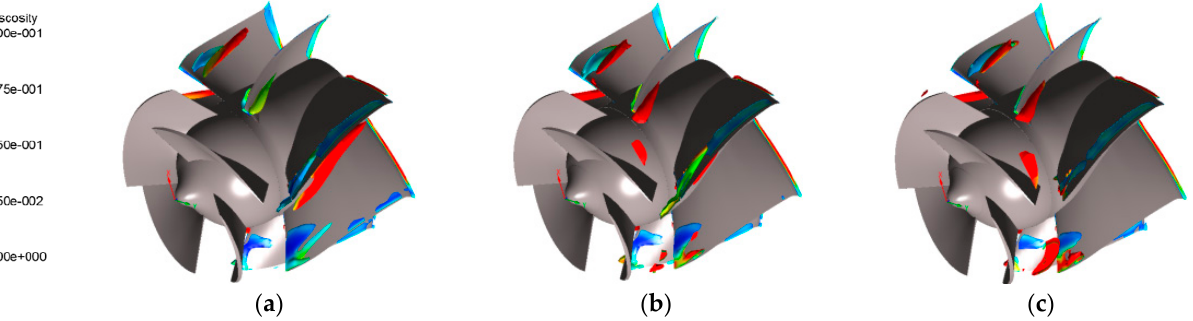
Figure 13. Vortex core distribution in guide vane, ( a ) e = 0 mm, ( b ) e = 3 × 10 − 1 mm, ( c ) e = 5 × 10 − 1 mm.